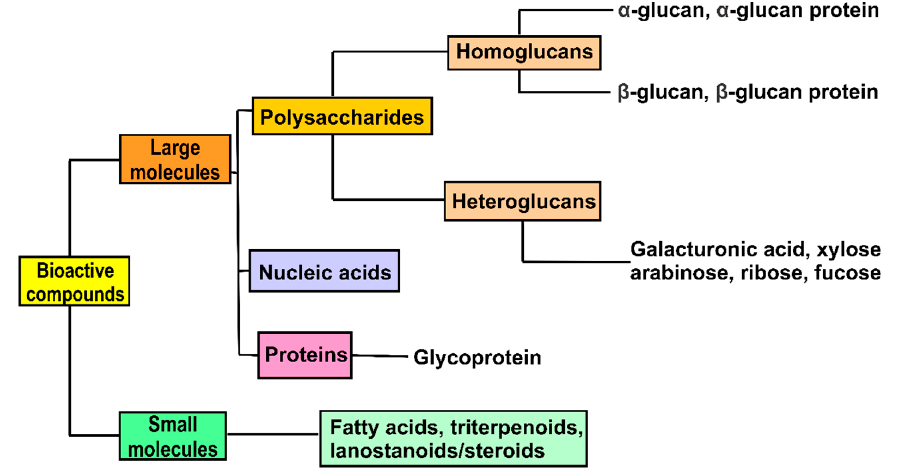
Figure 1. Classification of bioactive compounds isolated from mushrooms.